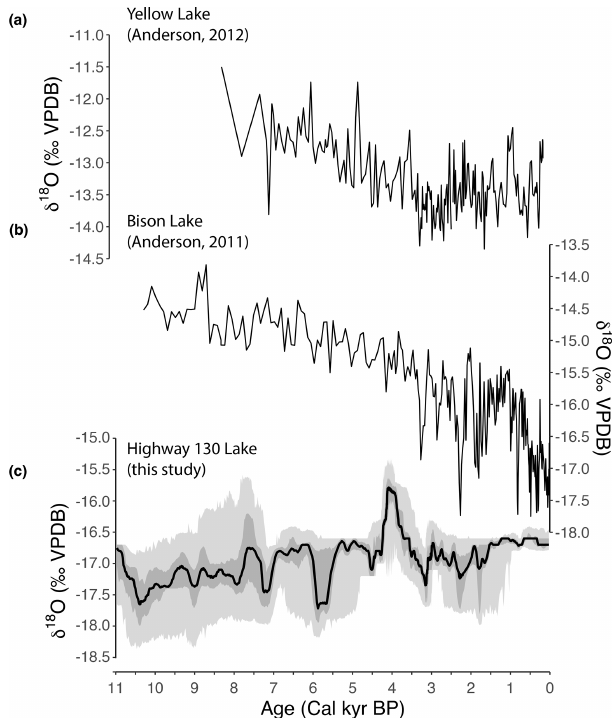
Figure 6. δ 18 O carb records from (a) Yellow Lake (Anderson, 2012), (b) Bison Lake (Anderson, 2011), and (c) Highway 130 Lake. In panel (c) the black line represents the median estimate of the ensemble regression, and the dark and light gray bands show the 50% and 95% highest-probability density regions,